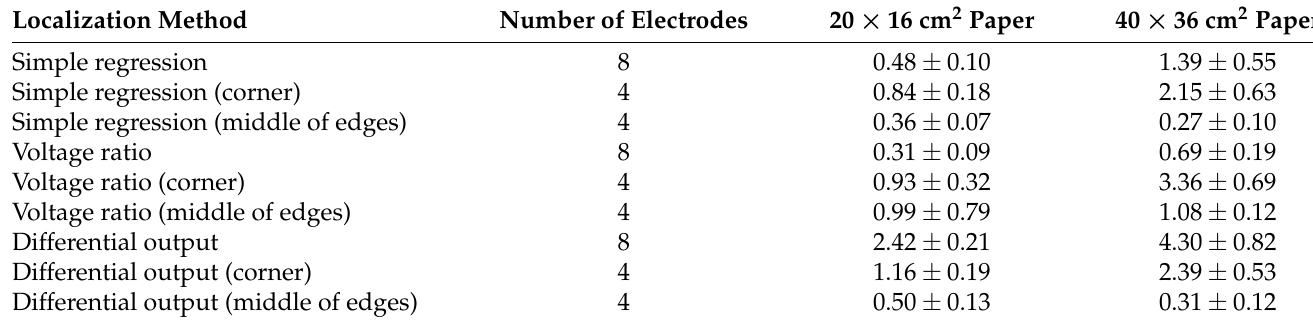
Table 1. Mean estimation error and standard deviation (cm) for each method.